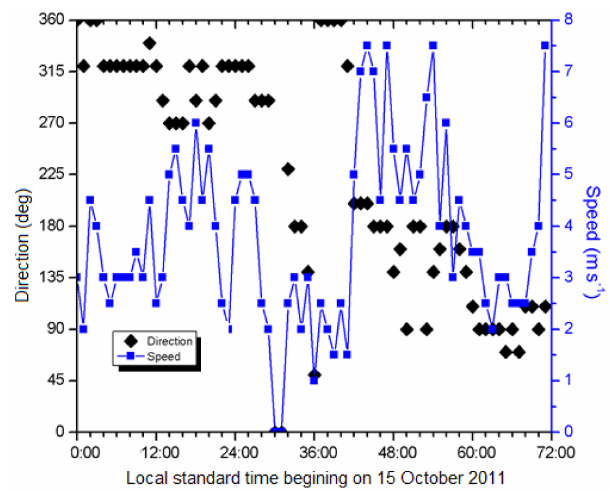
Figure 4. Surface wind speed (blue line, in ms − 1 ) and direction (black marker, in degrees) at